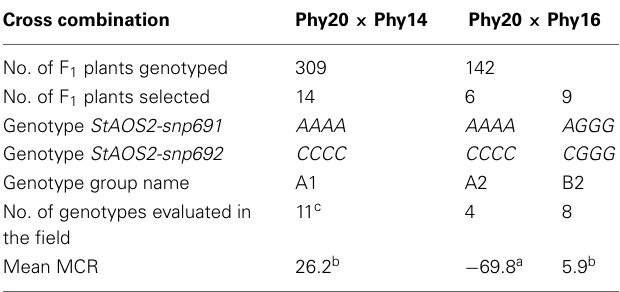
Table 1 | Summary of marker-assisted selection for